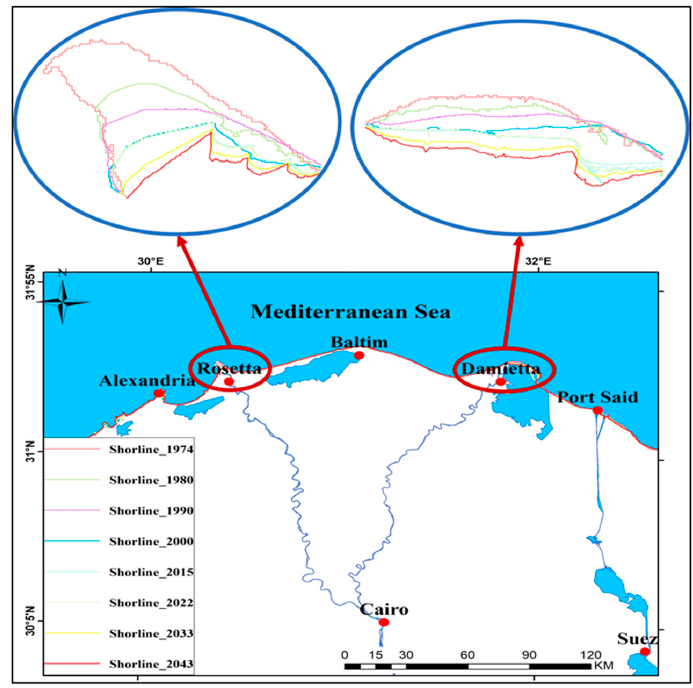
Figure 12. Shoreline changes at Rose tt a and Damie tt a in the period 1974–2043. Limited studies have been conducted on the shoreline change in the Nile Delta. The shoreline kinematics response due to the existence of protection measures at Damie tt a using satellite images was assessed by Esmail et al., (2019) [68]. Their study focused on the shoreline change during the period from 1990 to 2015 (25 years) based on four Landsat